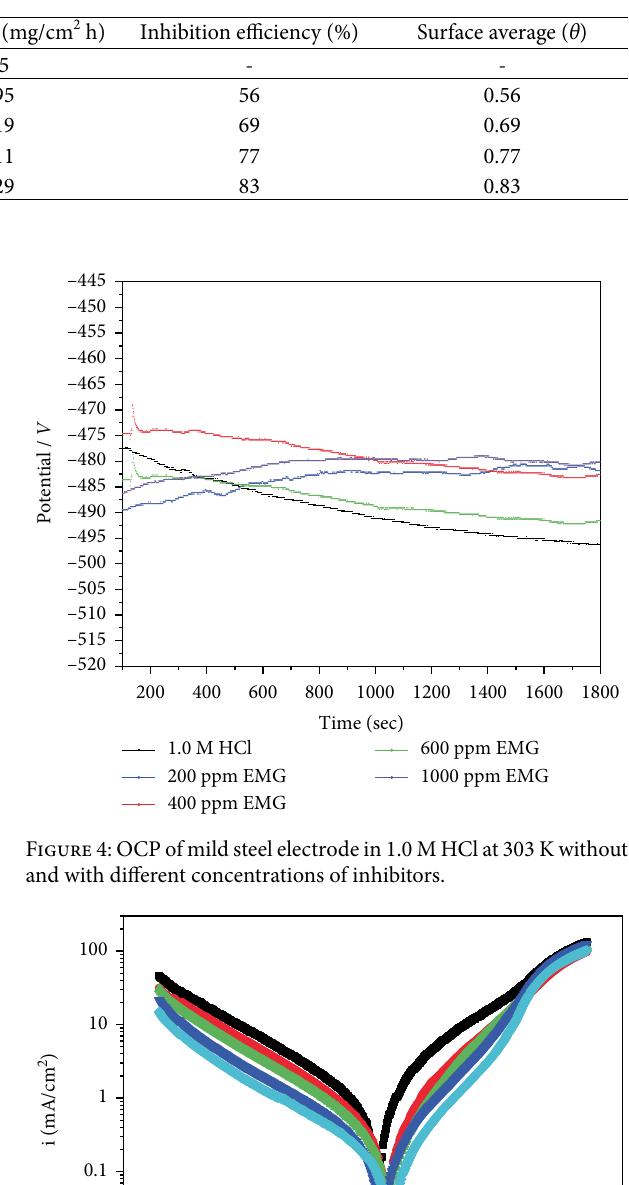
Table 3: Corrosion parameters obtained from weight loss measurements for carbon steel in 1.0 M HCl containing various concentration of EMG at 303 K.